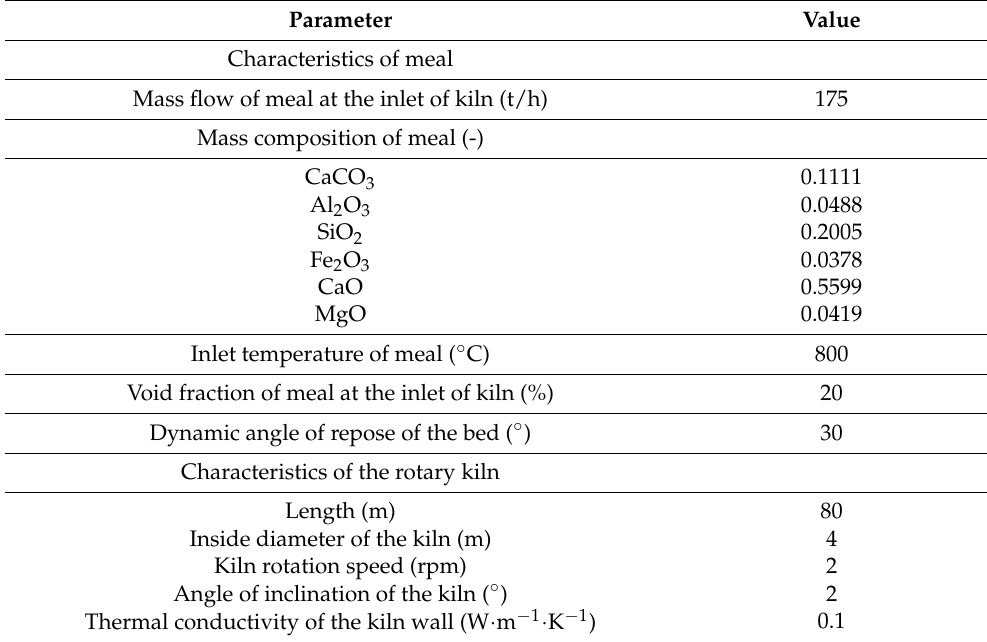
Table 3. Characteristics of meal at the inlet end of kiln and of its operation.